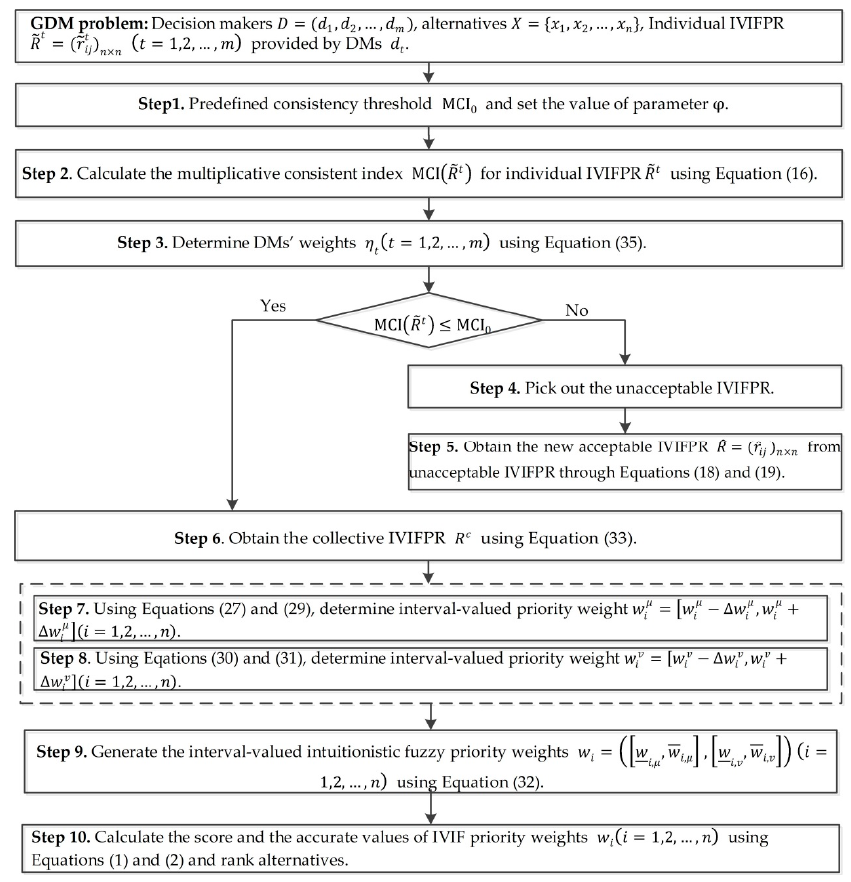
Figure 1. The flowchart of the whole steps for group decision making (GDM) with interval-valued intuitionistic fuzzy preference relations (IVIFPRs). intuitionistic fuzzy preference relations